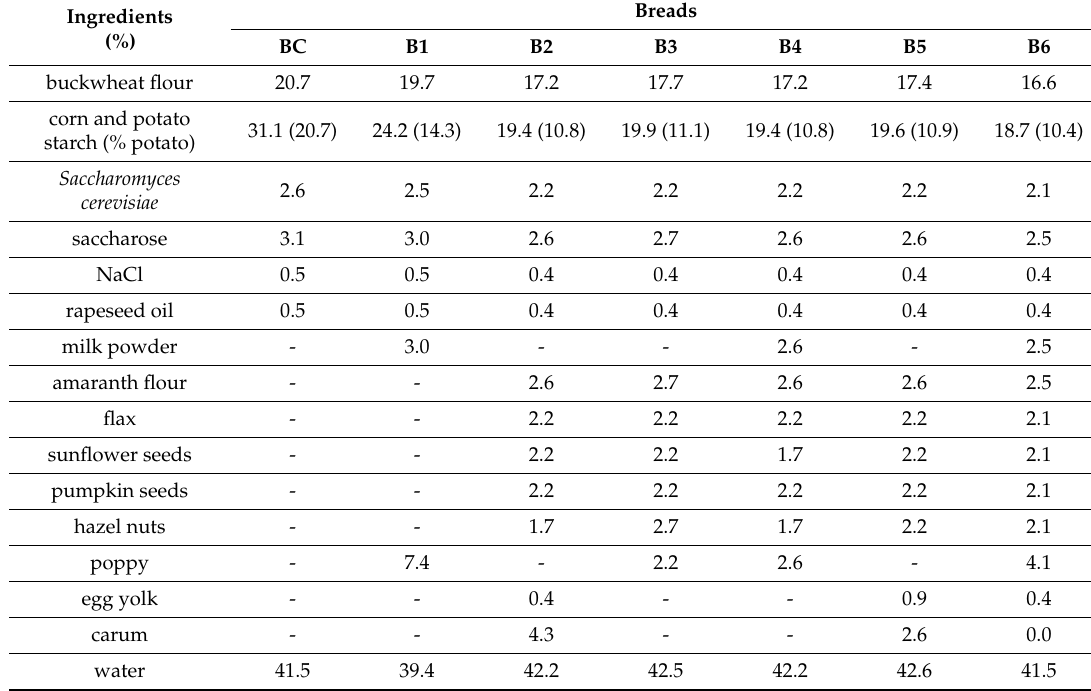
Table 1. Buckwheat breads’